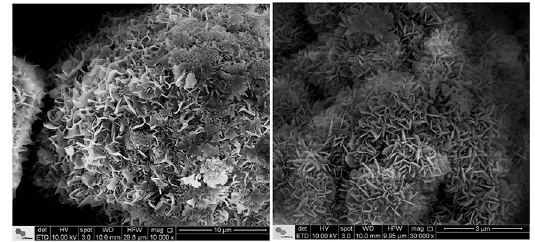
Figure 2: SEM micrograph showing the microstructure of the microspheres.